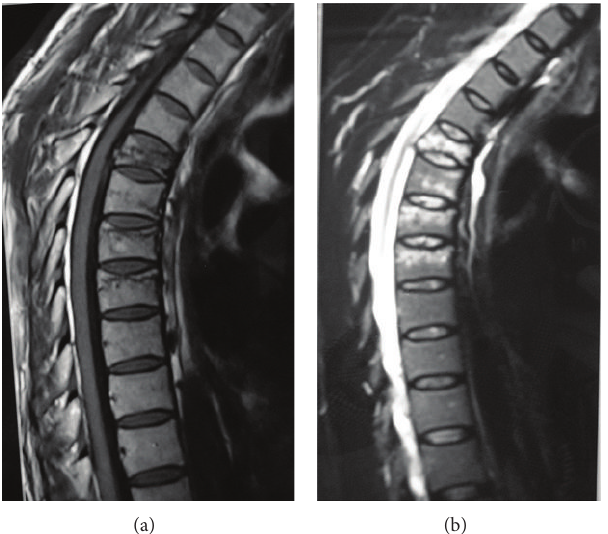
Figure 1: T1-weighted and T2-weighted sagittal magnetic resonance imaging (MRI) of the thoracic spine showing compression fracture at T5, T6, T7, and